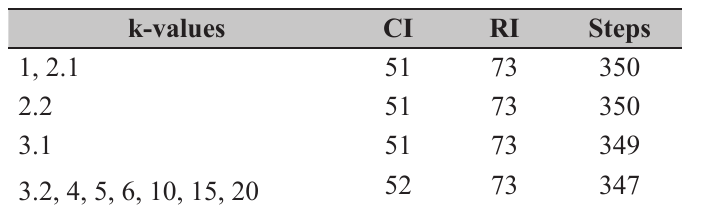
Table 4. Values of consistency index (CI), retention index (RI) and number of steps of the trees retrieved in analyzed here. The k-values (= 2 and 3) retrieved two different trees, represented here as 2.1, 2.2, 3.1 and 3.2.